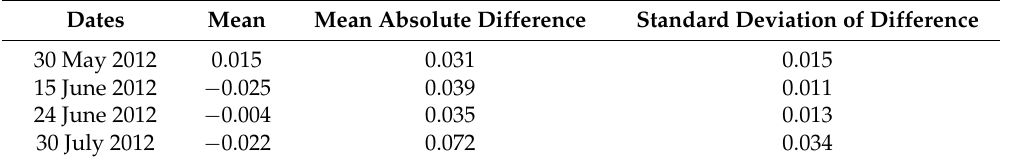
Table 5. Statistics of difference between MODIS and upscaled ASTER FAPAR.